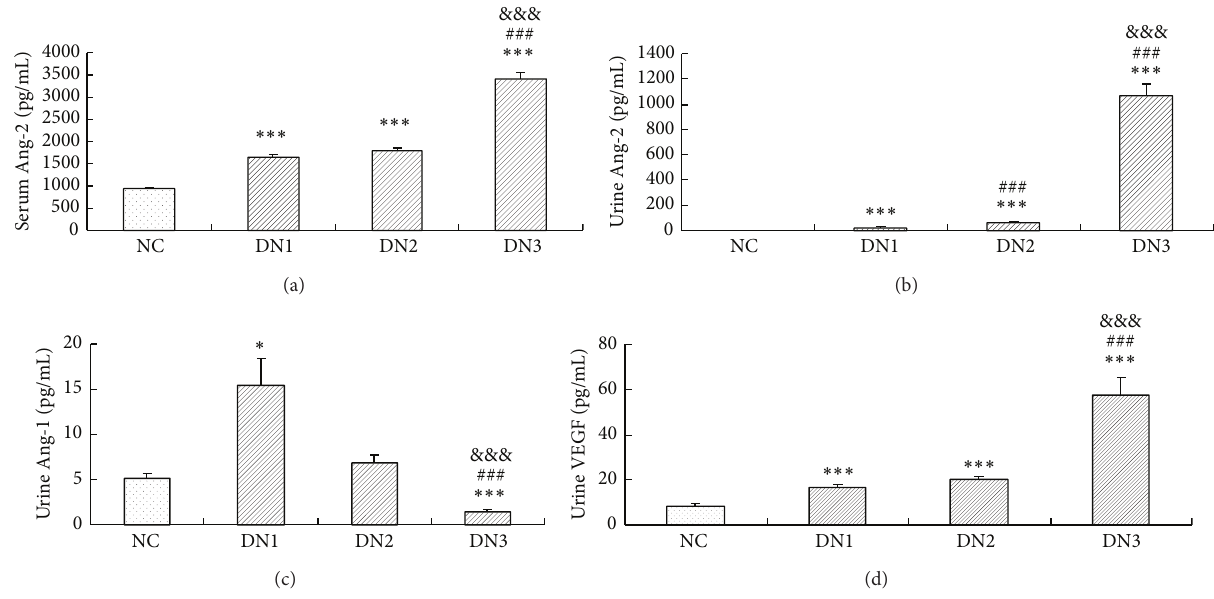
Figure 1: Serum and urinary angiogenic growth factor levels in diabetic patients and controls. (a) Statistical analysis showed increased serum concentrations of Ang-2 in diabetic patients compared with controls. (b) The level of urinary Ang-2 showed a stepwise increase in diabetic patients compared to controls according to the degree of albuminuria. (c) Urinary Ang-1 level was significantly higher in the DN1 group and lower in the DN3 group when compared with control subjects. Patients in the DN1 and DN2 groups exhibited significantly higher urinary Ang-1 levels than those in the DN3 group. (d) Subjects with diabetes mellitus showed significantly higher urinary VEGF levels than control subjects. Patients were divided into DN1 (normal-albuminuria), DN2 (microalbuminuria), and DN3 (macroalbuminuria) groups. ∗ 𝑃 < 0.05